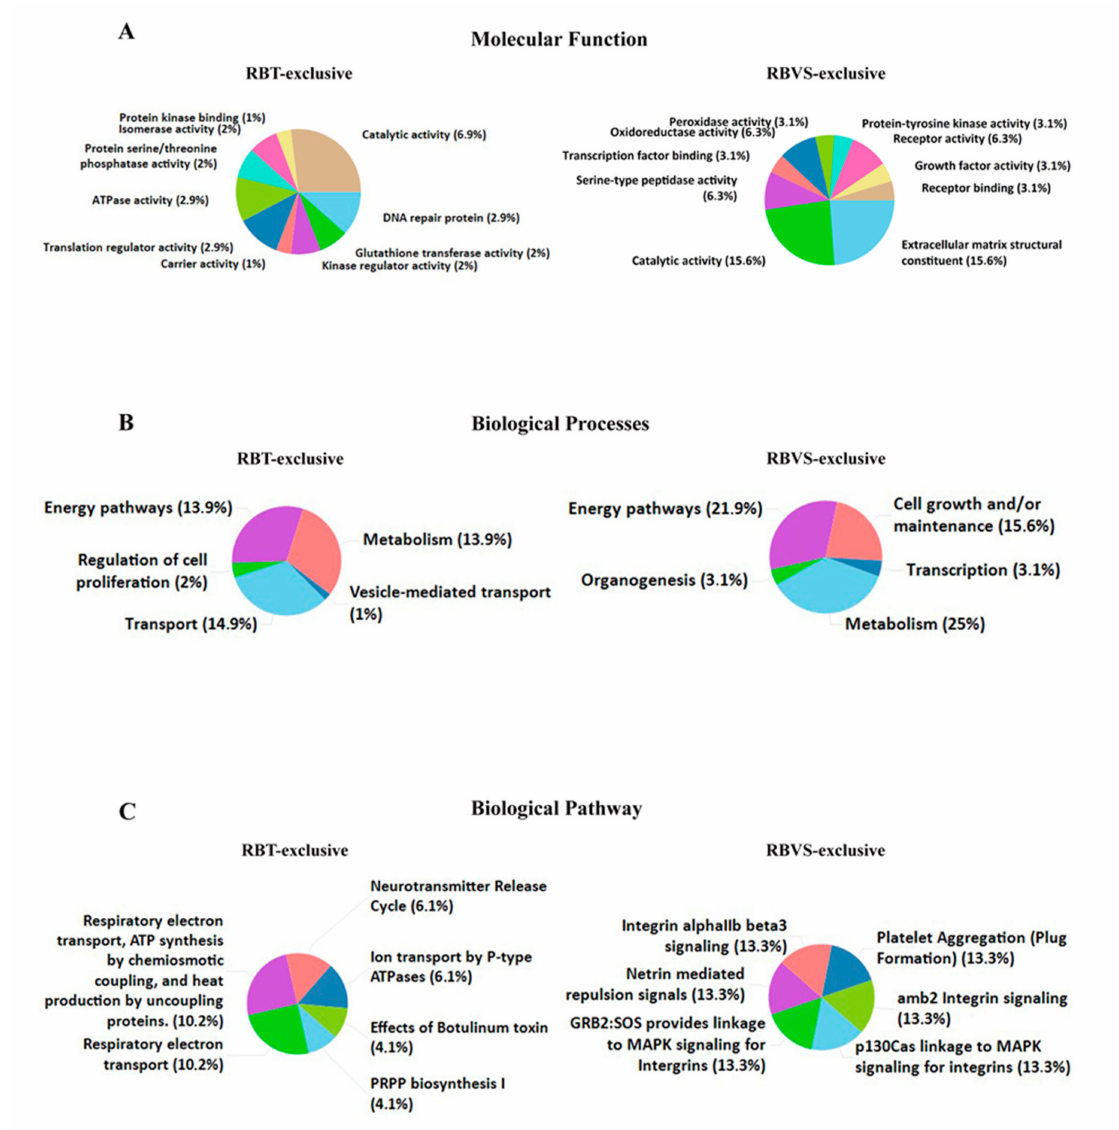
Figure 4. Exclusive RBT- and RBVS-exosomal proteins. Graphical representation of the molecular function ( A ), biological processes ( B ) and biological pathway ( C ) gene enrichment obtained by FunRich software for the 99 and 35 proteins found exclusively in RBT- or RBVS-derived exosomes, respectively. 2.4. Di ff erentially Expressed Proteins in RBT- and RBVS-Derived Exosomes and Their Network Principal component analysis (PCA) was performed to visualize any similarities or di ff erences between samples derived from RBT or RBVS cell lines. The two-dimensional plot shows that exosomal proteins from primary tumor (RBT1, RBT2, RBT5, RBT14) are well separated from proteins of vitreous seeding cell lines (RBVS1, RBVS3, RBVS10) (Figure